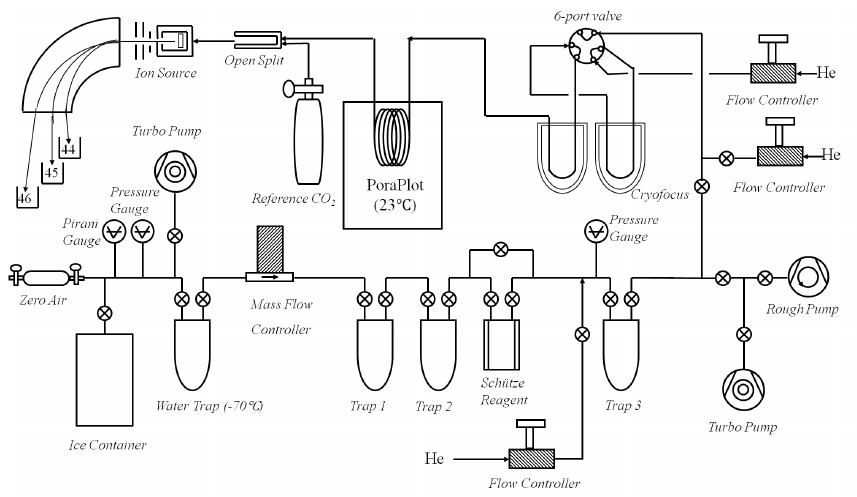
Fig. 1. A schematic diagram of the system used for mixing ratio, δ 13 C and δ 18 O analysis of atmospheric CO and ice core CO. See details in the